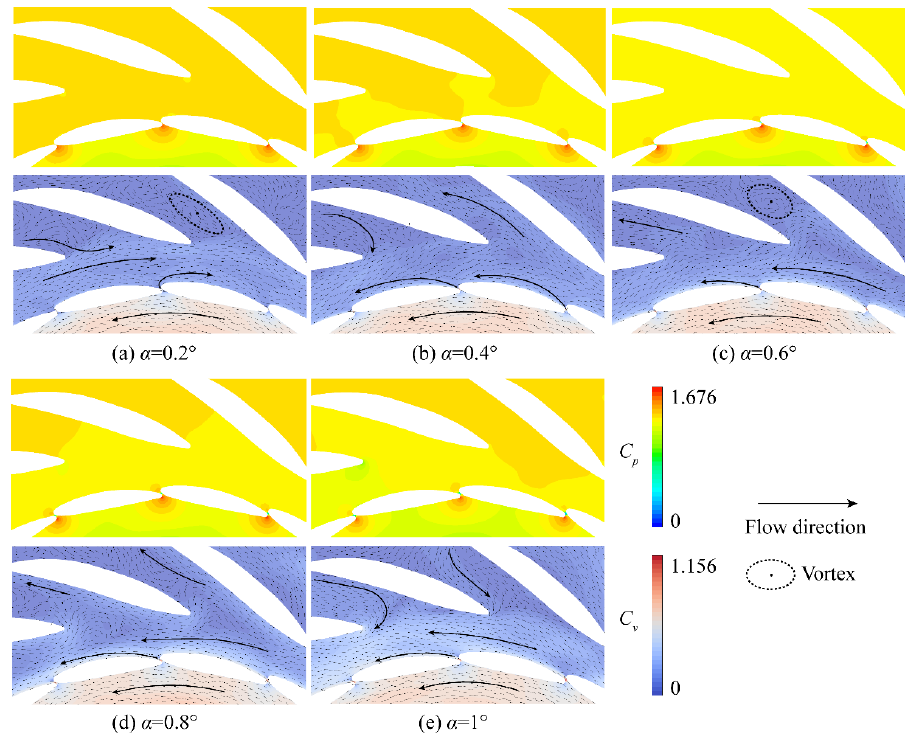
Figure 13. Contours of C p and contours of C v with vectors on the mid-section plane at different opening angles of GV-M under the condition of C ψ = 1.133.